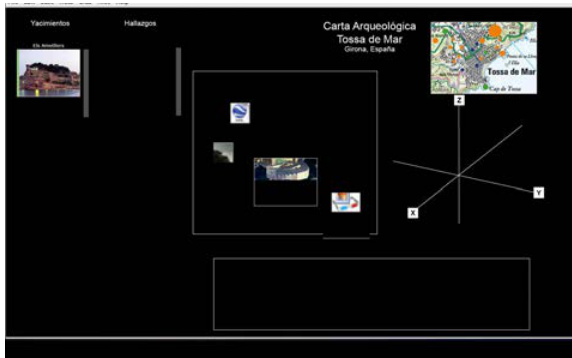
Figure 4. The 3D Collaborative Environment: Archaeological site selection, 3D